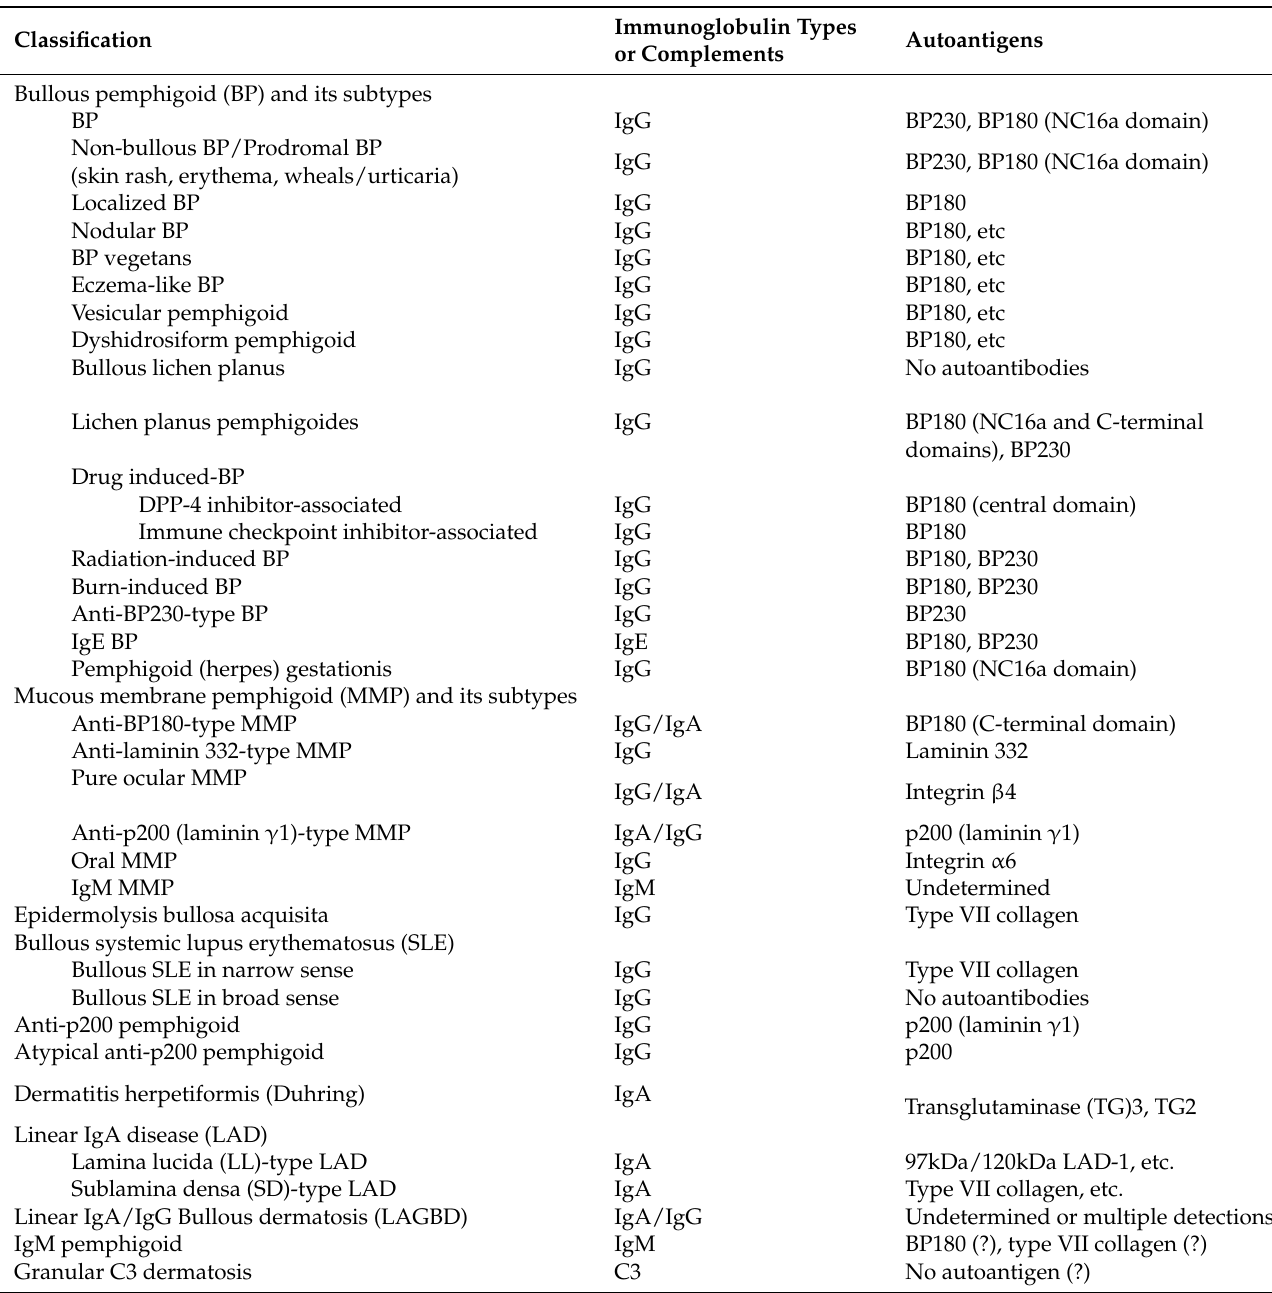
Table 2. Classification, immunoglobulin types and autoantigens of pemphigoid